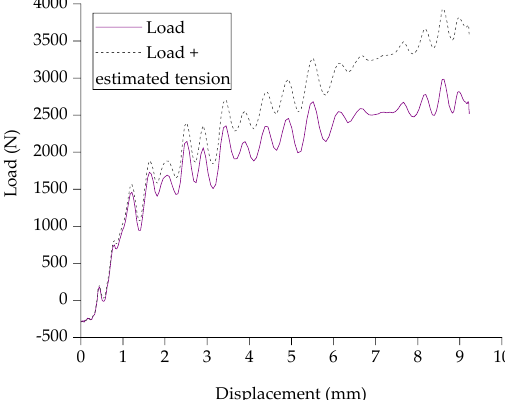
Figure 4. Plot of measured load and measured load + estimated diaphragm tension with respect to displacement.